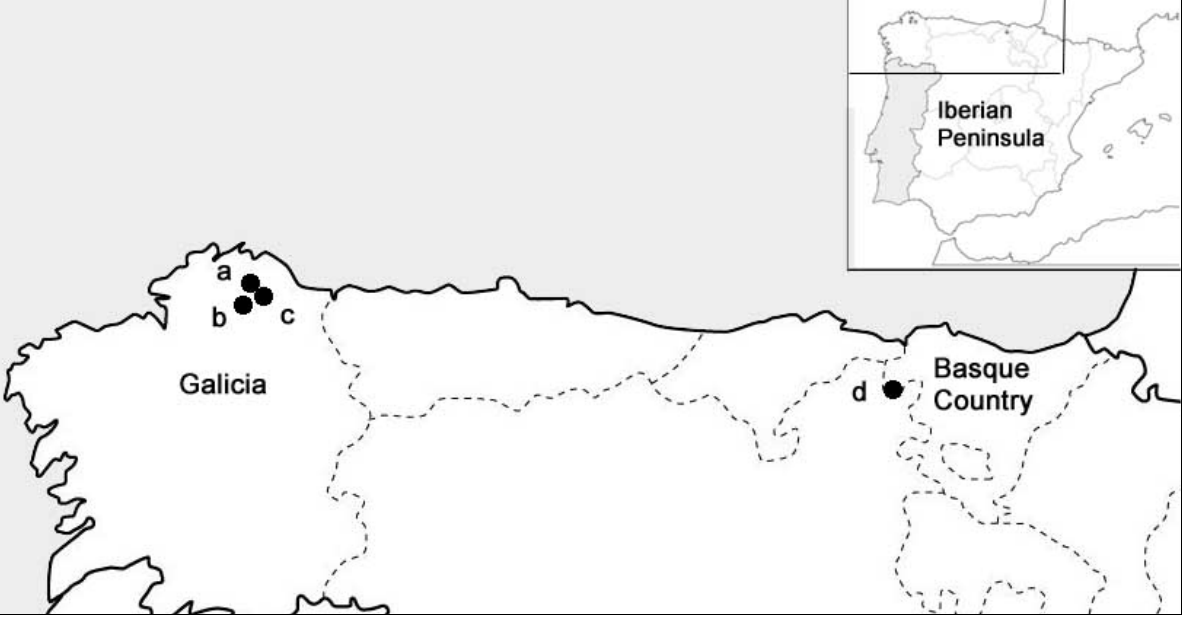
Figure 1. Locations of the sampled bogs: a) CVM (Chao de Veiga Mol), b) PDC (Pena da Cadela), c) BCG (Borralleiras de Cal Grande), d) ZAL